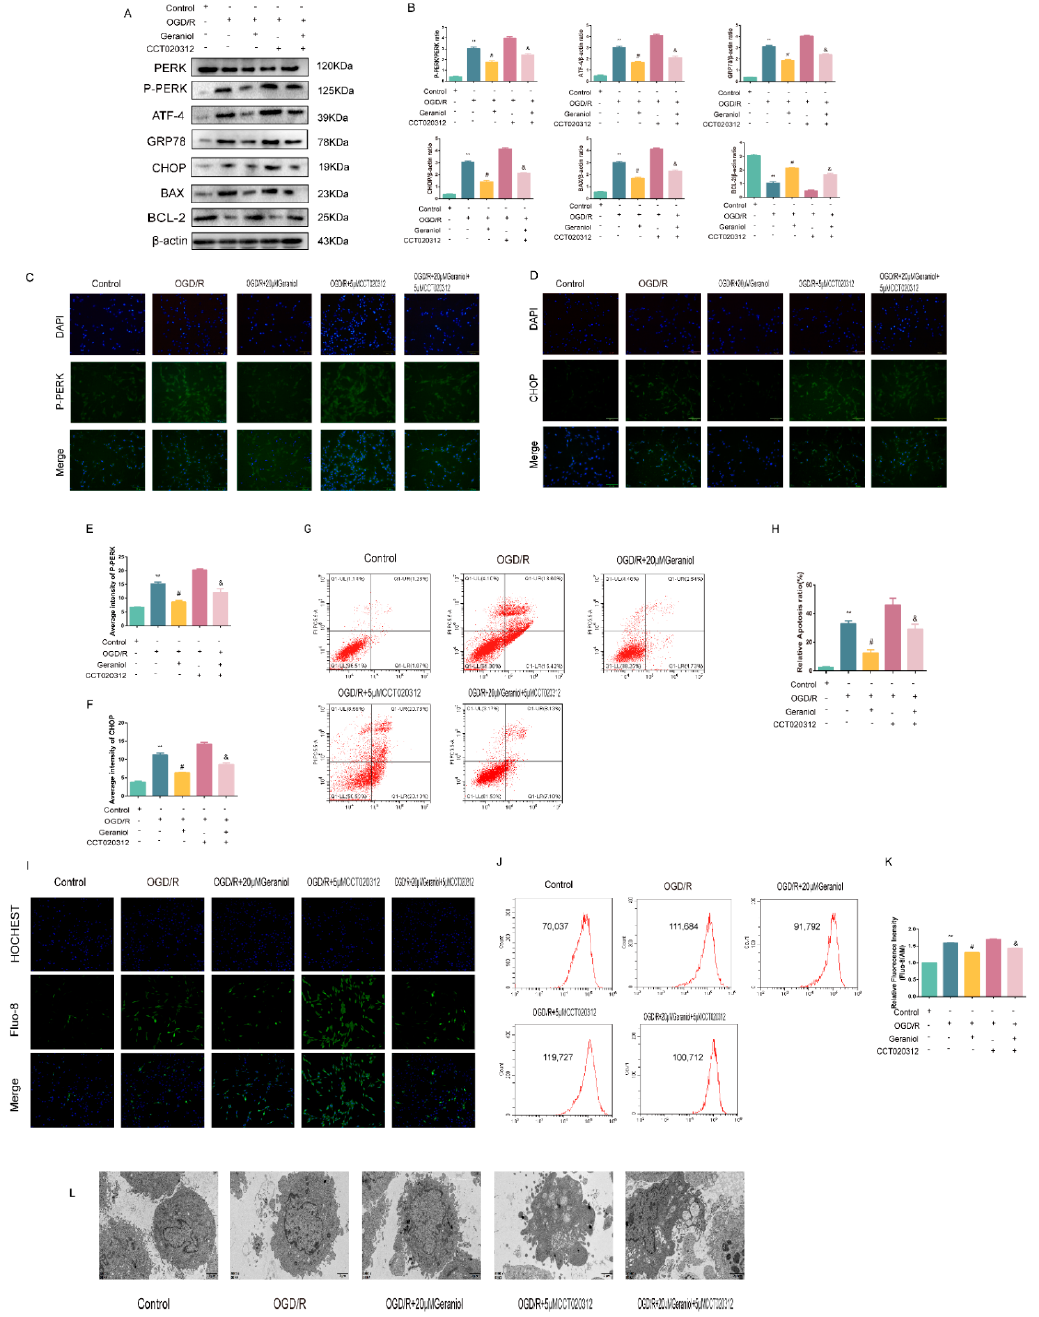
Figure 10. Inhibition of endoplasmic reticulum stress via the PERK-ATF4-CHOP pathway is re- quired for the geraniol-mediated protective effect against oxygen–glucose deprivation/reoxygenation (OGD/R) injury in PC12 cells. ( A , B ) Western blot analysis of PERK, P-PERK, ATF4, GRP78, BAX, BCL-2, and CHOP expression ( n = 6). ( C – F ) Immunofluorescence staining of P-PERK and CHOP in the cortex. Representative images were acquired under 400 × magnification, scale bars = 50 µ m ( n = 3). ( G , H ) Apoptosis detection via flow cytometry ( n = 3). ( I ) The intracellular calcium ion concentration was detected via Fluo-8/AM staining using laser confocal microscopy. Bar = 200 µ m. ( J , K ) Flow cytometry detection of intracellular calcium ion concentration via Fluo-8/AM staining ( n = 3). ( L ) Cell transmission electron microscopy (20,000 × ). ** p < 0.01 OGD/R group vs. control group, # p < 0.01 OGD/R + 20 µ M geraniol group vs. OGD/R group, & p < 0.01 OGD/R + 20 µ M geraniol + 5 µ M CCT020312 group vs. OGD/R + 20 µ M geraniol